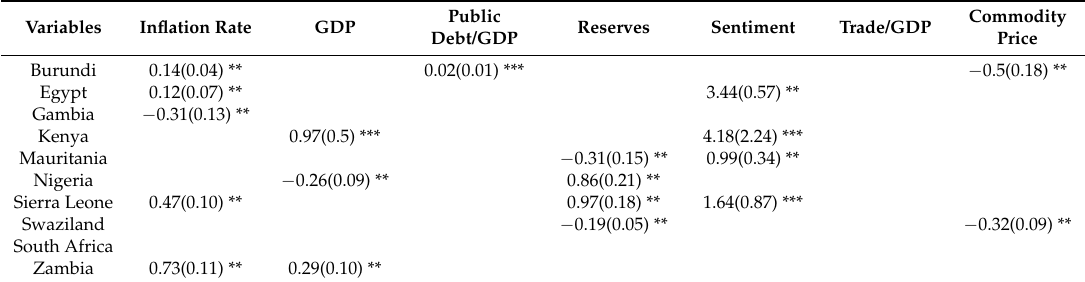
Table 5. Generalized Method of Moment estimation